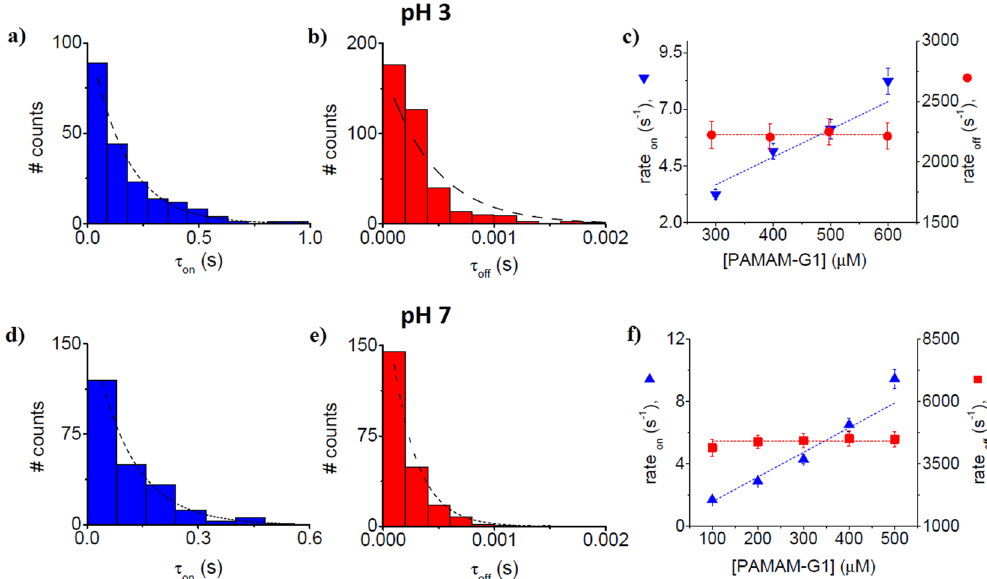
Figure 3. The kinetics description of PAMAM-G1 – α -HL interactions, at acidic and neutral pH. Representative histograms of the inter-event ( τ on ) and blockade duration intervals ( τ off ) characterizing the PAMAM-G1 – α -HL reversible interactions recorded at a transmembrane potential of Δ V = + 100 mV, in 1 M KCl, at pH = 3 (panels a and b) and pH = 7 (panels d and e). At distinct concentrations of the dendrimer, such histograms were fitted with a mono-exponential function, and corresponding reaction rates describing the PAMAM-G1 – α -HL interactions were derived.